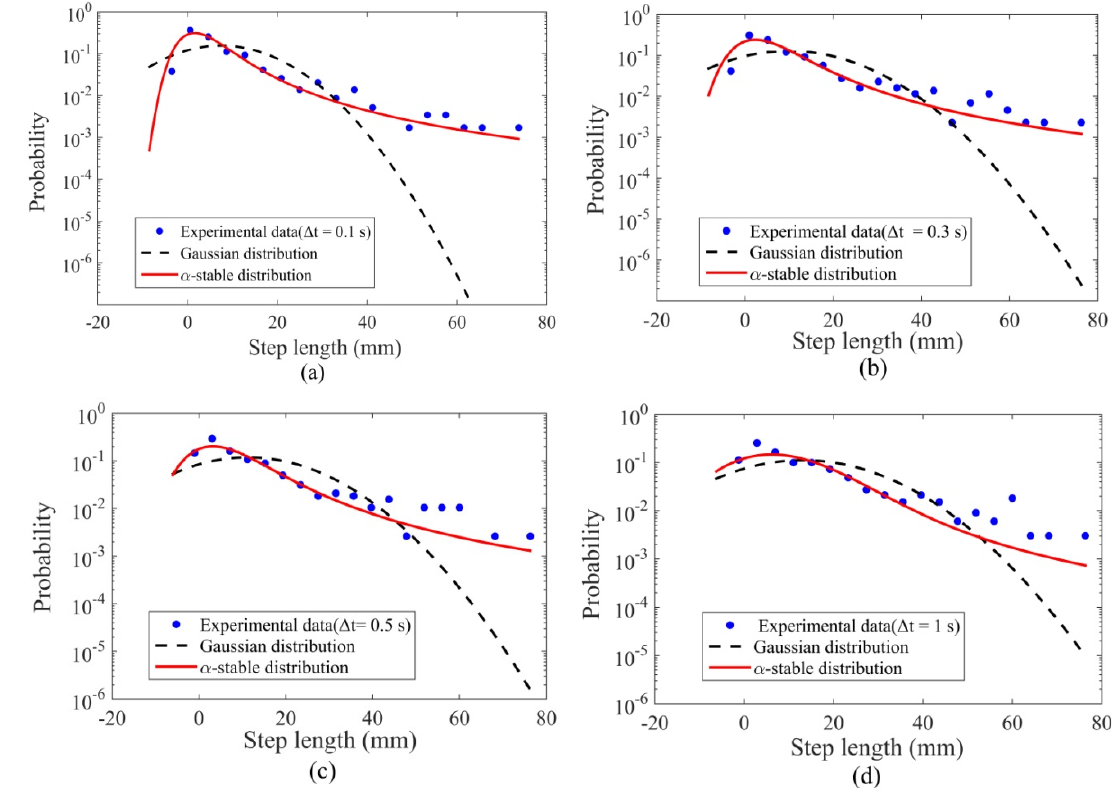
Figure 9. Changes in the probability density function (PDF) of the particle step length for observation intervals of Δ t = 0.1 s ( a ), 0.3 s ( b ), 0.5 s ( c ) and 1 s ( d ) on semilog plots with theoretical lines representing Gaussian and α -stable distributions.